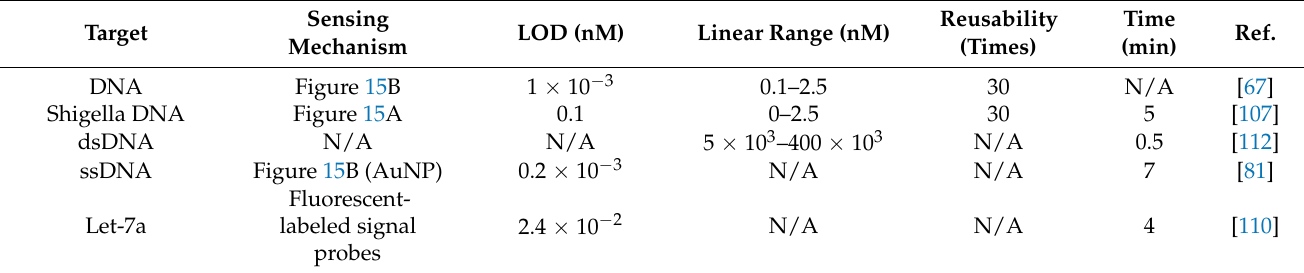
Table 3. Detection of nucleic